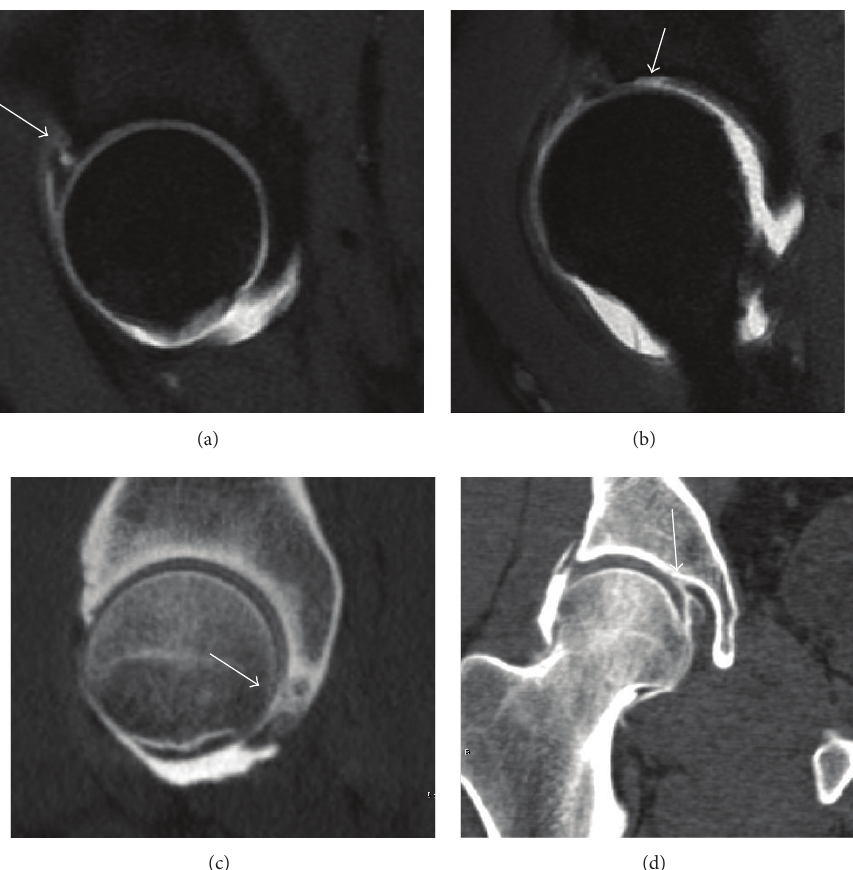
Figure 9: Sagittal T1 weighted images showing anterosuperior labral tear (a) and chondral lesion (b). Sagittal CT-arthrography showing posteroinferior chondral injury (c) and coronal CT-arthrography (d) showing ligamentum teres tear.